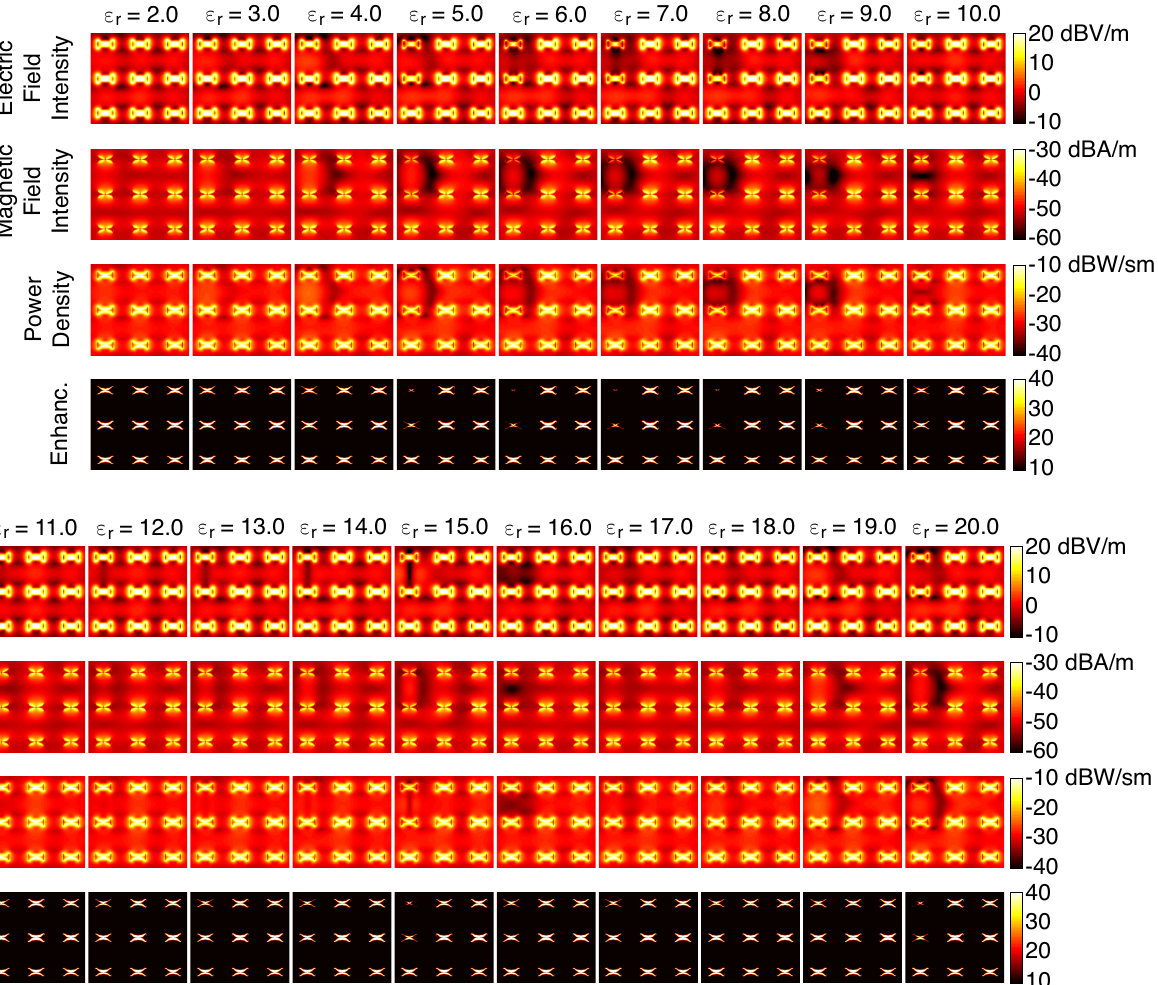
Figure 9: Near-zone characteristics of an array of 3 × 3 nanoantennas when dielectric particles of diameter 300 nm are located above the array. The periodicity of the array is 475 nm. The particles are 90 nm away from the top surfaces of the